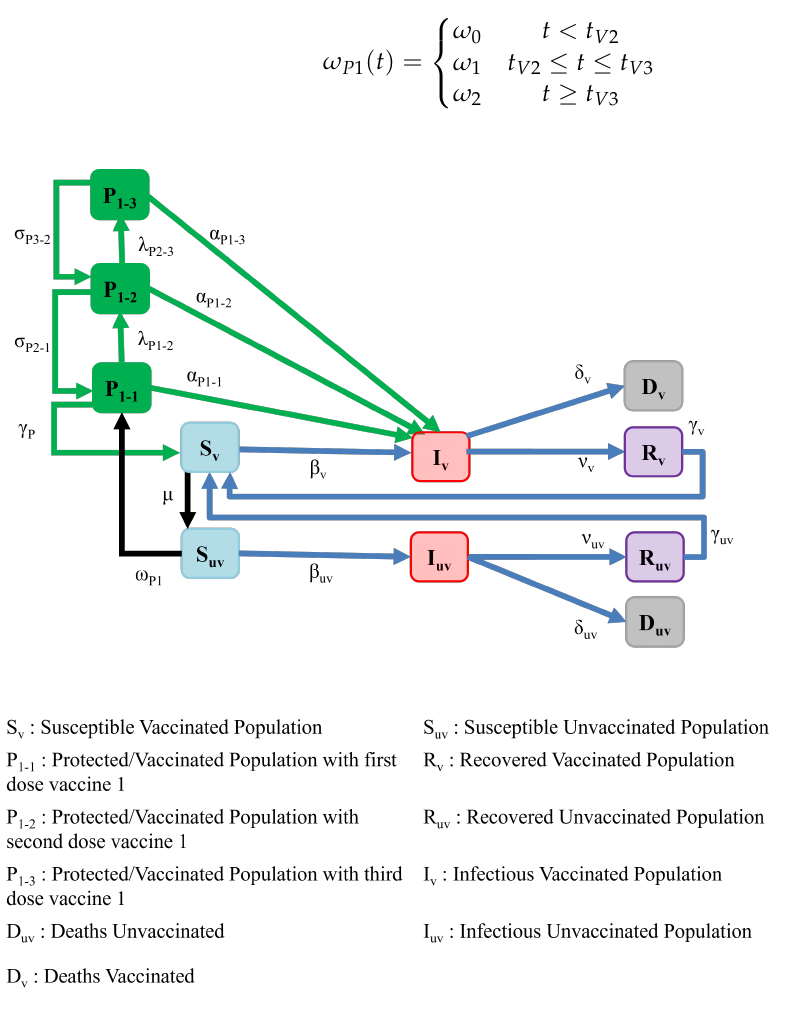
Figure 10. Model of multi-dose immunization and vaccinated and unvaccinated